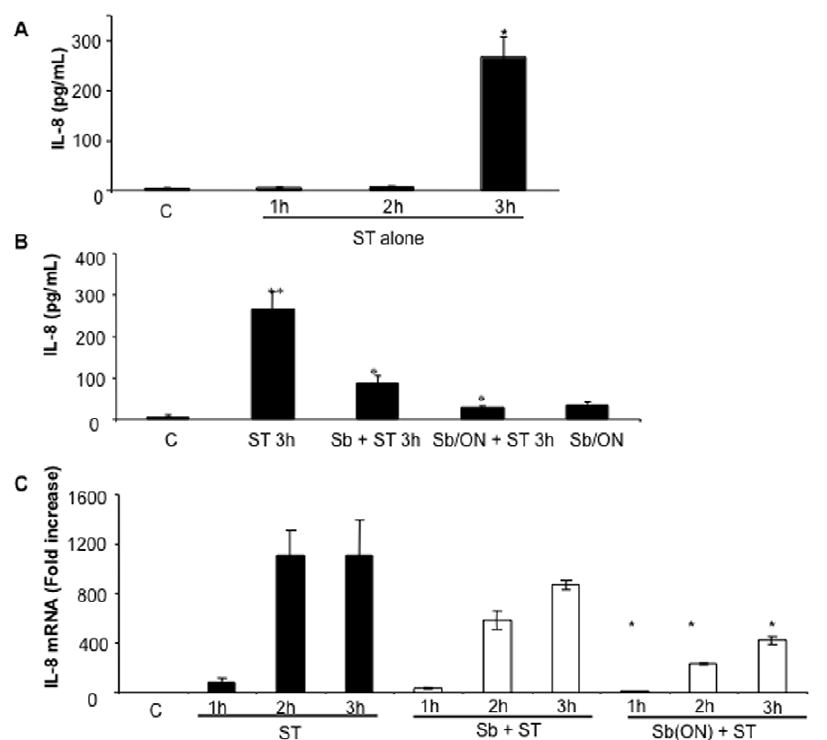
Figure 8. S. boulardii prevents IL-8 secretion and synthesis in S. Typhimurium infected cells. Pro-inflammatory response of T84 monolayers in response to S. Typhimurium infection in the absence (A) or presence (B) of S. boulardii . (A) At indicated time of infection, medium was collected and IL-8 content was estimated by ELISA. The asterisk indicates that the value is significantly different from the value for uninfected control cells (P , 0.01), as determined by the Bonferroni-Dunn tests. (B) IL-8 content was estimated in the supernatant of T84 cells after 3 h of infection with ST in the presence (curative and preventive protocol) or absence of S. boulardii . Errors bars indicate standard deviations. An asterisk denotes significantly different versus ST-infected cells and two asterisks denotes significantly different versus control cells (P , 0.05) when compared by the Student’s t -test. ON, overnight. The data in A and B are expressed as means 6 SEMs (n=8). (C) IL-8 mRNA content was estimated in T84 cells by real time PCR after 1, 2 and 3 h of infection with ST in the presence (curative and preventive protocol) or absence of S. boulardii . Errors bars show the SEMs. An asterisk denotes significantly different versus ST-infected cells (P , 0.05, n=6) when compared by the Student’s t -test. ON, overnight.